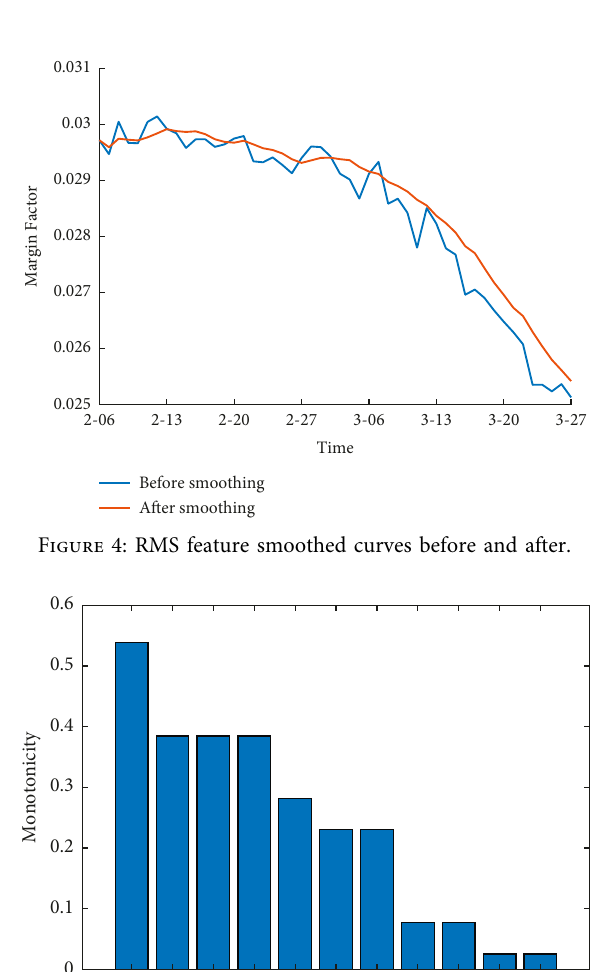
Figure 3: Three time-domain characteristic curves of 50-day monitoring data: (a) mean, (b) margin factor, and (c)